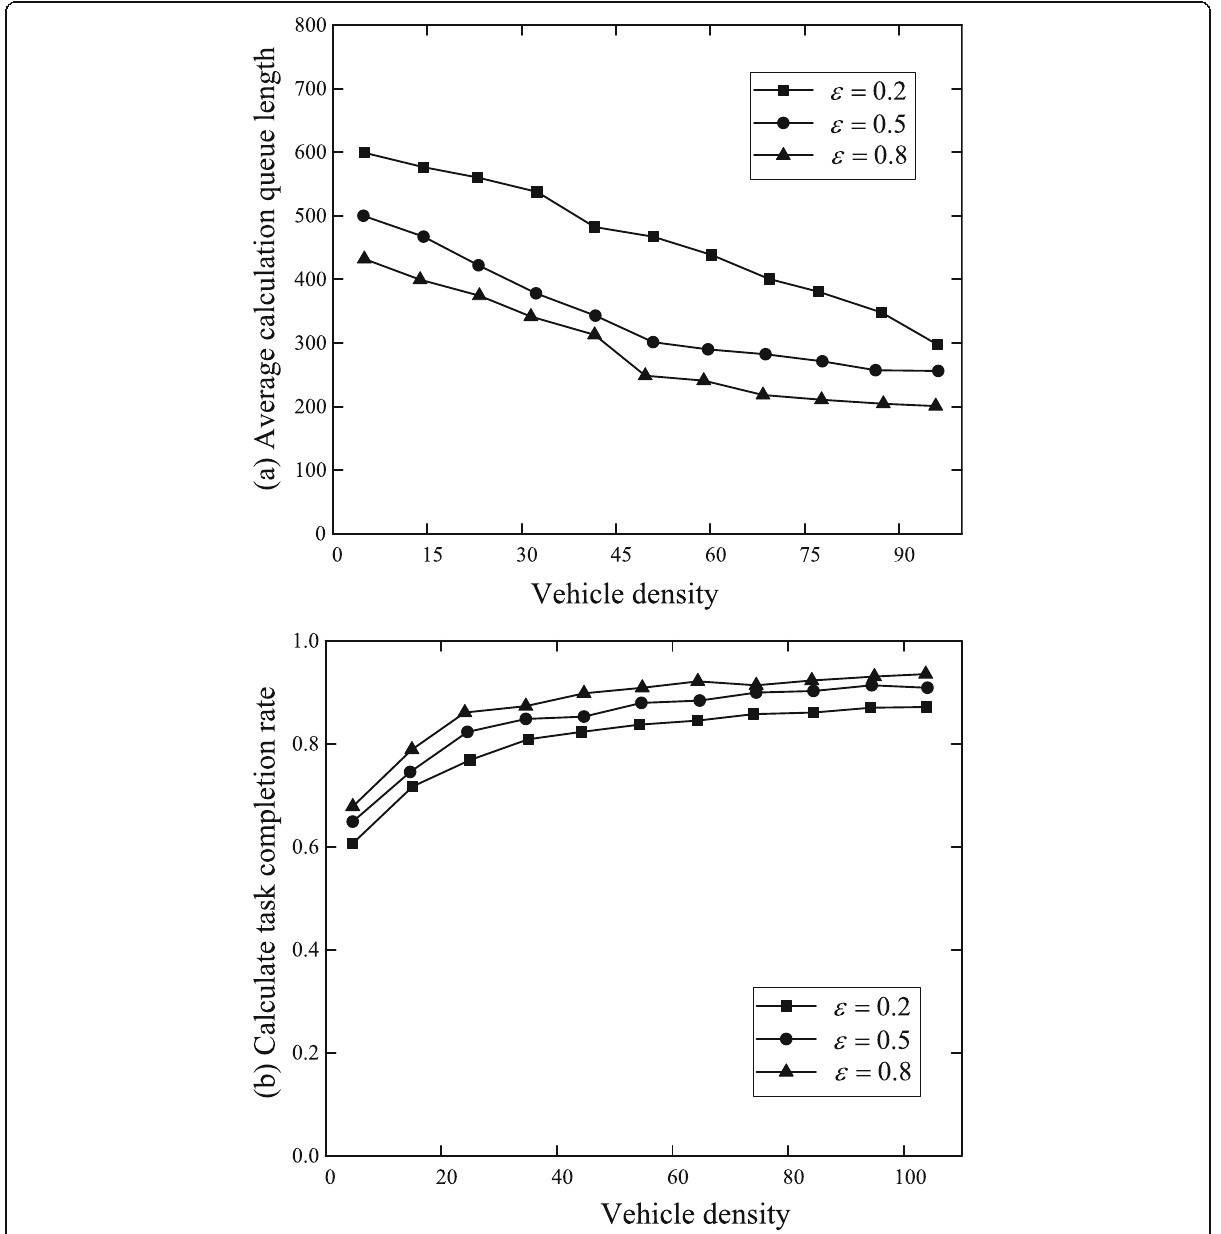
Fig. 7 Comparison of the results for the proposed scheduling strategy under different greedy